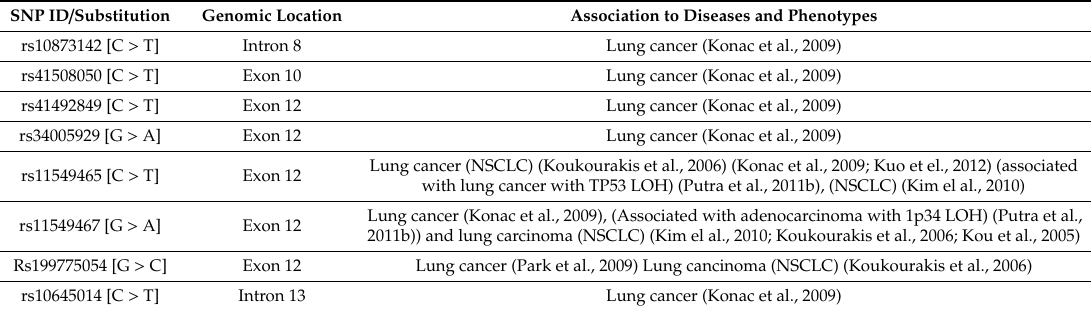
Table 1. SNP ID / substitution, genomic location, and association to diseases and phenotypes of lung cancer.